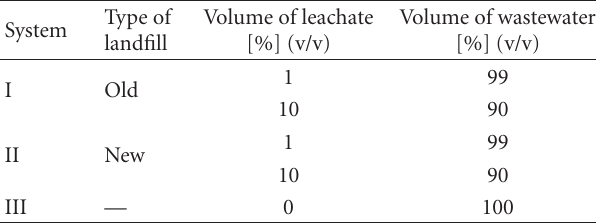
Table 1: Composition of influent of systems I, II, and III.